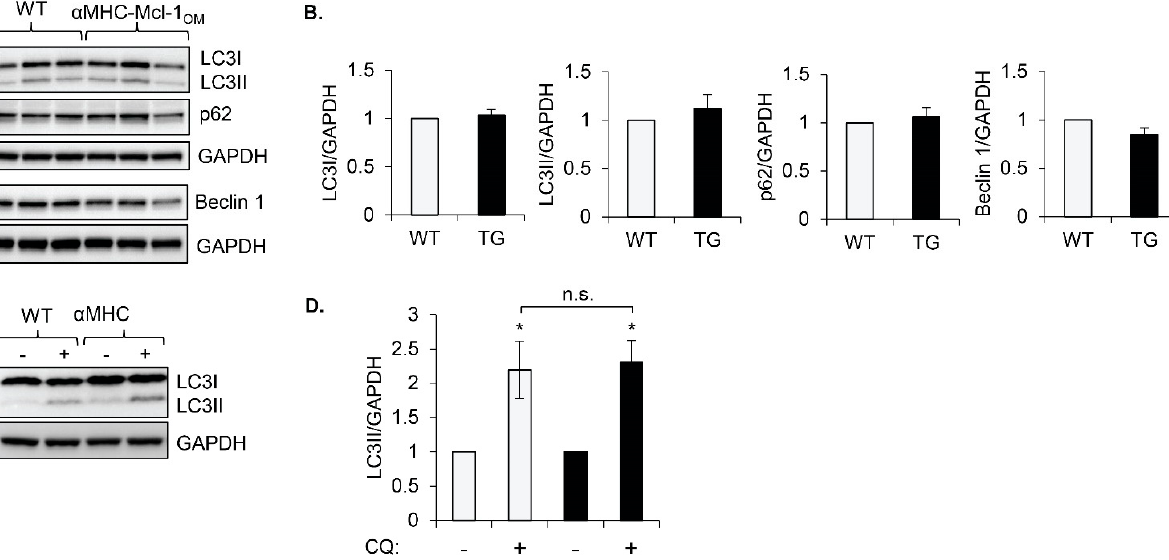
Figure 1. Baseline autophagic activity in hearts is not inhibited by Mcl-1 OM overexpression. ( A ) Rep- resentative Western blots of LC3, p62, and Beclin1 protein levels in hearts of WT and α MHC- Mcl-1 OM mice. GAPDH was used as a loading control. ( B ) Quantification of LC3I, LC3II, p62, and Beclin1 protein levels ( n = 3–5). ( C ) Representative Western blots of LC3 and GAPDH protein levels in hearts of WT and α MHC- Mcl-1 OM mice after injection with vehicle ( − ) or 80 mg/kg chloroquine (CQ) (+) for 2 h. ( D ) Quantification of LC3II levels ( n = 4–5, * p < 0.05 vs. CQ ( − ); n.s., not significant). WT = wild type, TG = transgenic. Data are mean ± SEM. Statistical tests: Student’s t-test or ANOVA, followed by Bonferroni’s multiple comparison test.